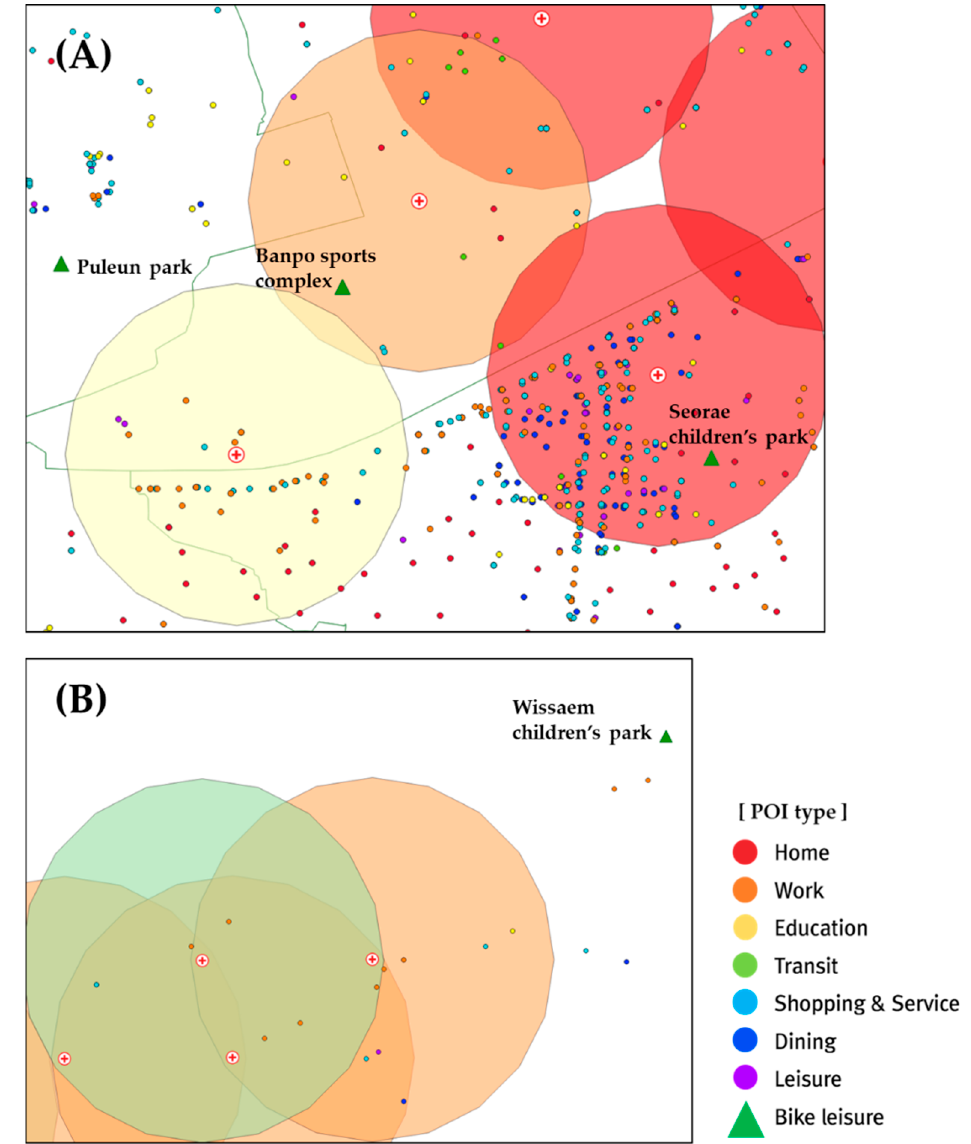
Figure 9. Visualization of POI distributions within a